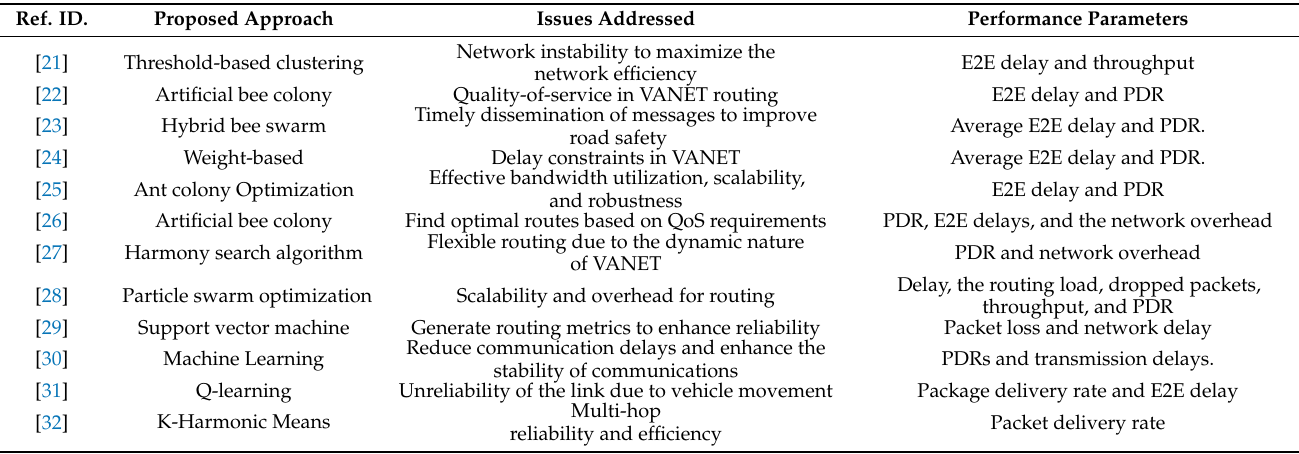
Table 1. Evaluation of surveyed protocols in